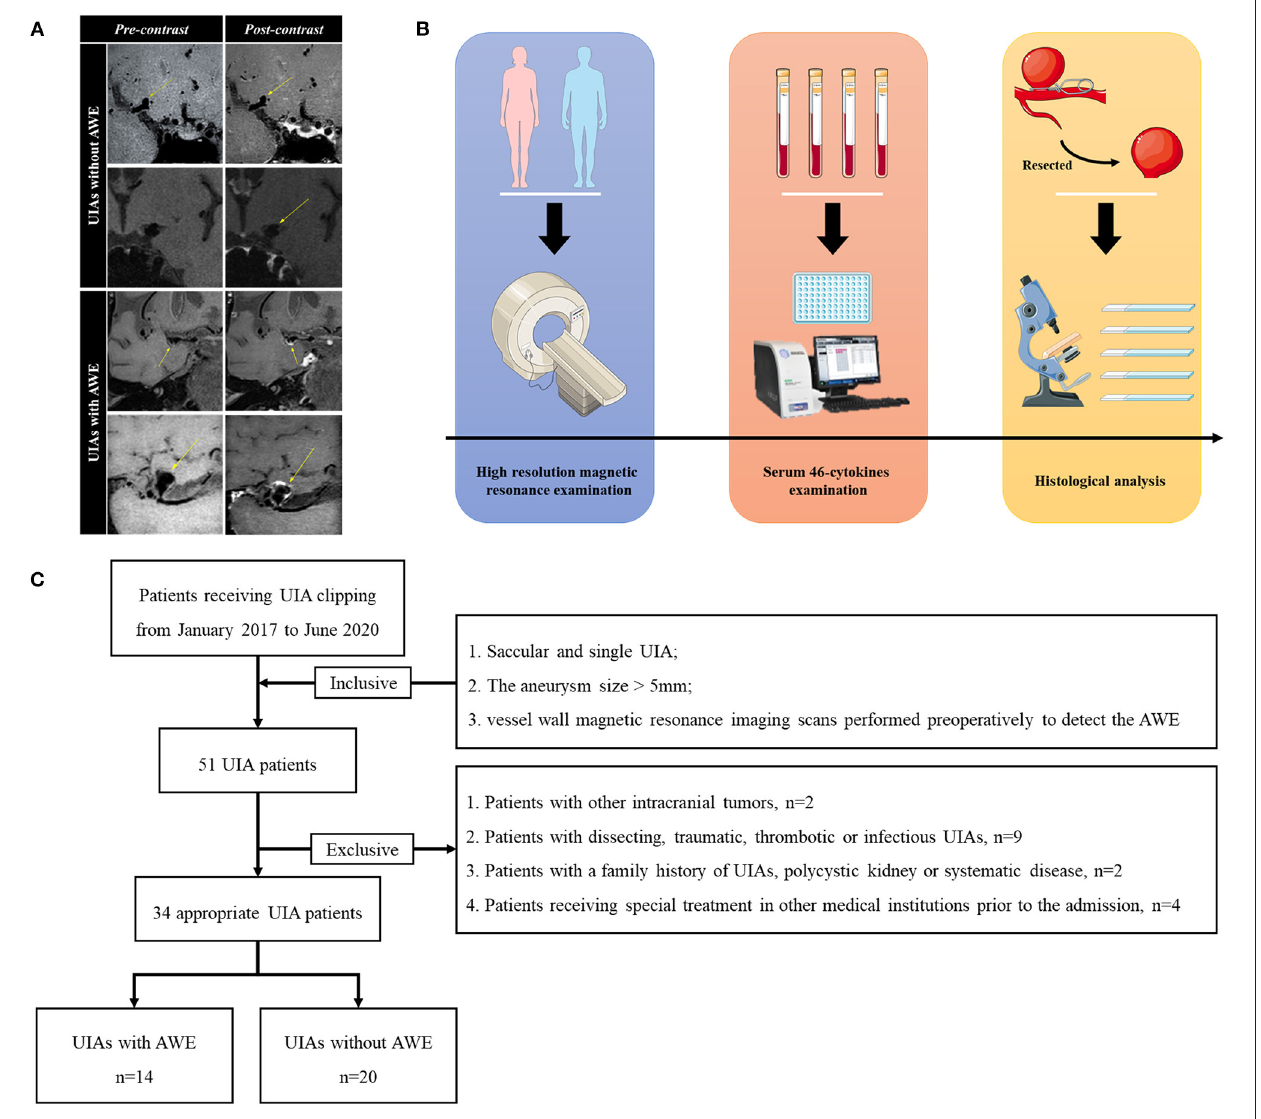
FIGURE 1 | The diagram of analysis. (A) Four representative cases of UIAs with and without AWE. To be specific, the pre-contrast and post-contrast statues of UIAs were presented. (B) The diagram of analysis. Preoperatively, the appropriate UIA patients would receive high-resolution magnetic resonance examinations. The blood samples of the mentioned patients would be tested with the 46-cytokines examination. After appropriate clipping, the UIAs would be resected for the histological analysis. (C) The flow chart of patient enrollment. This study finally recruited 34 UIA patients. UIA, unruptured intracranial aneurysm; AWE, aneurysm wall